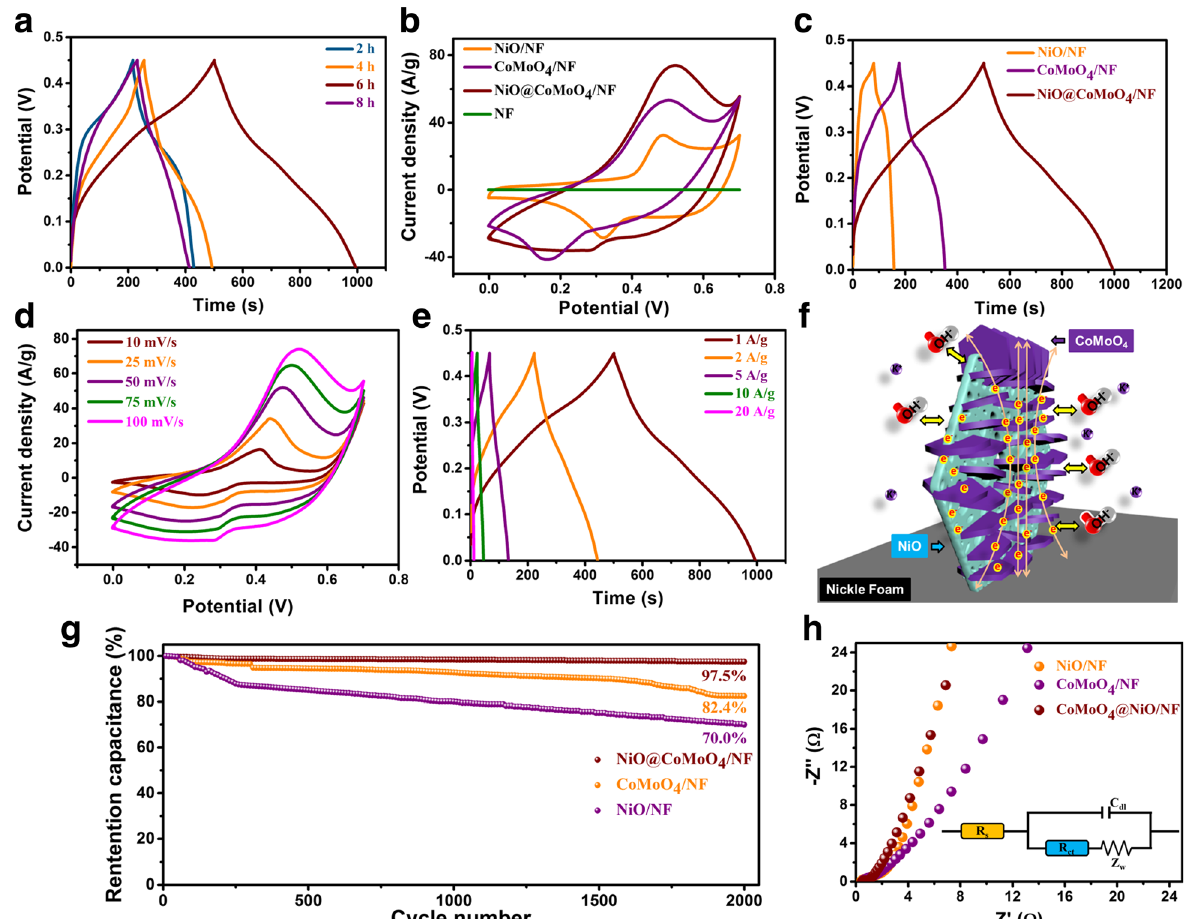
Fig. 5 a GCD curves of NiO flakes@CoMoO 4 NSs/NF electrodes obtained at different reaction time (2 h, 4 h, 6 h, and 8 h) at current density of 1 A/g. b CV curves of NiO flakes/NF, CoMoO 4 flakes/NF, and NiO flakes@CoMoO 4 NSs/NF electrodes at scan rate of 100 mV/s. c GCD curves of NiO flakes/NF, CoMoO 4 flakes/NF, and NiO flakes@CoMoO 4 NSs/NF electrodes at current density of 1 A/g. d CV curves of NiO flakes@CoMoO 4 NSs/NF electrode at different scan rates. e GCD curves of NiO flakes@CoMoO 4 NSs/NF electrode at different current densities. f The schematic diagram of structural advantages for NiO flakes@CoMoO 4 NSs/NF. g Cycle stability of different electrodes up to 2000 cycles. h EIS spectra of NiO flakes/NF, CoMoO 4 flakes/NF, and NiO flakes@CoMoO 4 NSs/NF